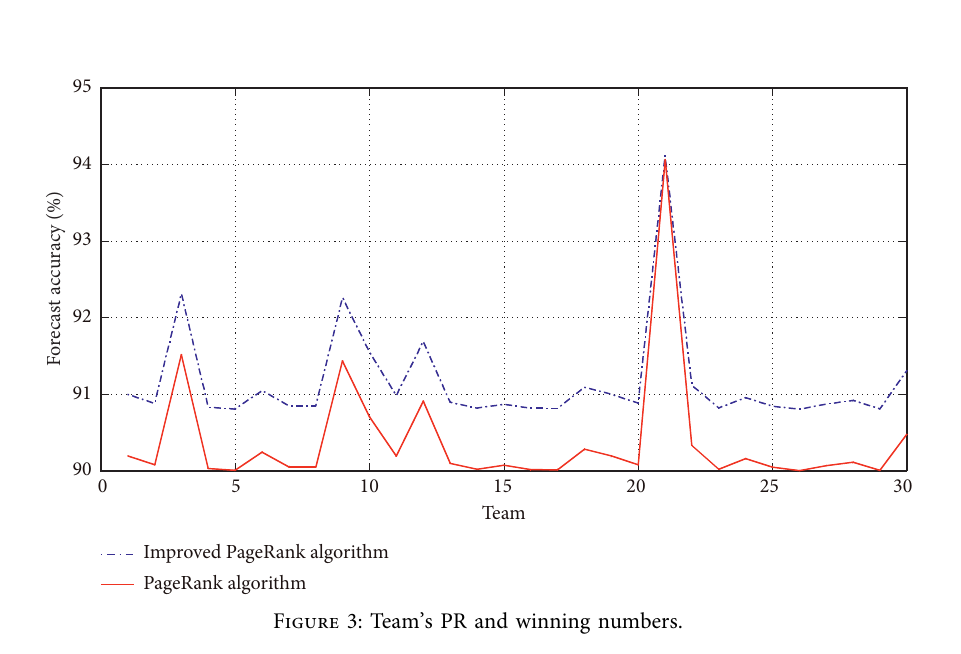
Figure 3: Team’s PR and winning numbers.